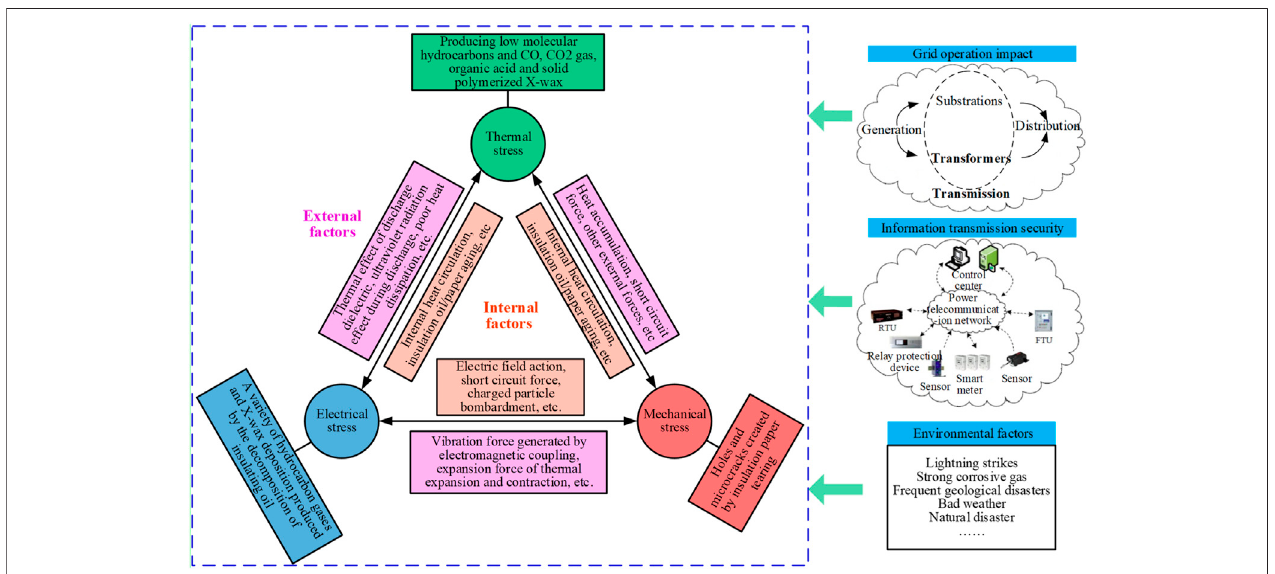
FIGURE 2 | Main factors related to transformer operation.